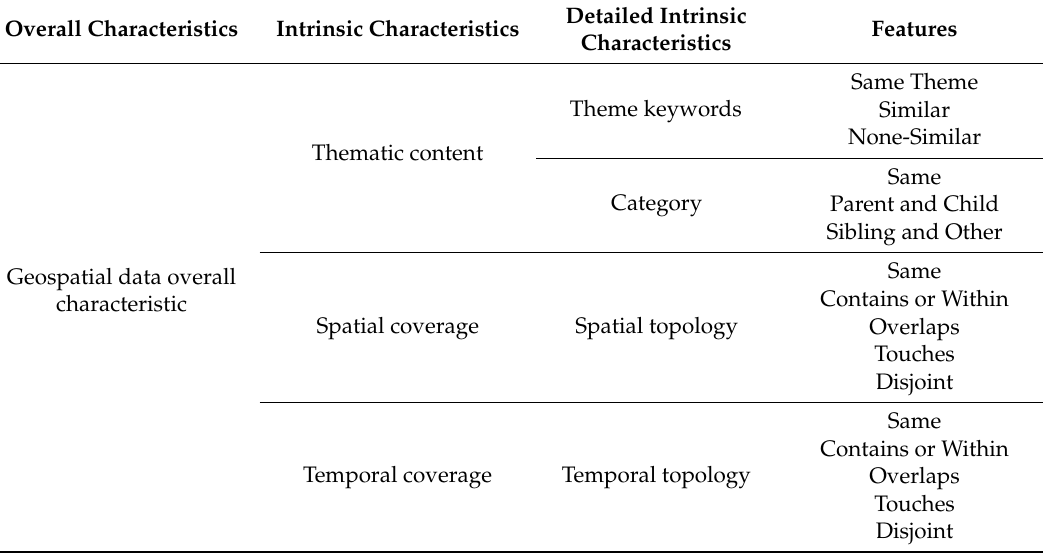
Table 4. Features of each detailed intrinsic